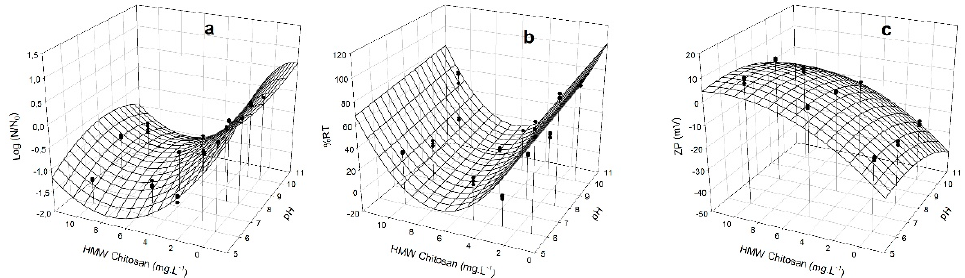
Figure 6. Response surface plot for M. aeruginosa CAAT 2005 ‐ 3 of: ( a ) log (N/N 0 ), ( b ) %RT removal; and ( c ) ZP of the clarified zone, as a function of different concentrations of HMW chitosan (mg L − 1 ) and pHs. (•) experimental measurements.